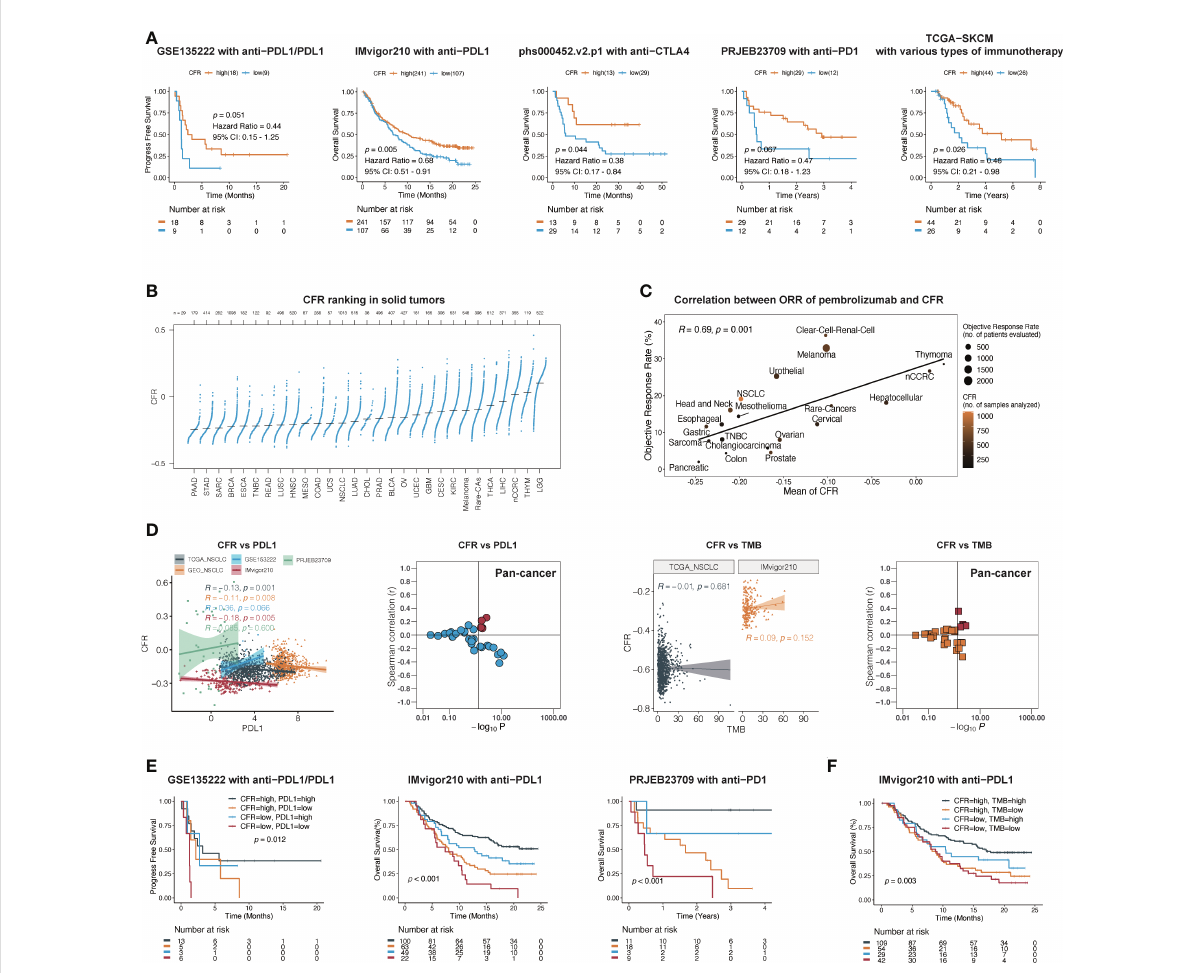
FIGURE 4 CFR is a predictive biomarker of immunotherapy across multiple cancers. (A) In fi ve independent cohorts, Kaplan – Meier survival curves compare overall survival between CFR high and CFR low groups. (B) Distribution pattern of CFR in pan-cancer. Tumors are ordered by the median CFR from highest to lowest. (C) A correlation between CFR and objective response rate with pembrolizumab therapy in 20 solid tumor types. nCCRC, non-clear cell renal carcinoma; NSCLC, non-small cell lung cancer; rare tumors include adrenocortical carcinomas, paraganglioma- pheochromocytoma, and germ cell tumors. (D) A correlation between PD-L1 mRNA expression, TMB, and CFR in independent cohorts. (E, F) Kaplan – Meier curves of OS according to CFR combined with PD-L1 in a cohort or TMB in a cohort,